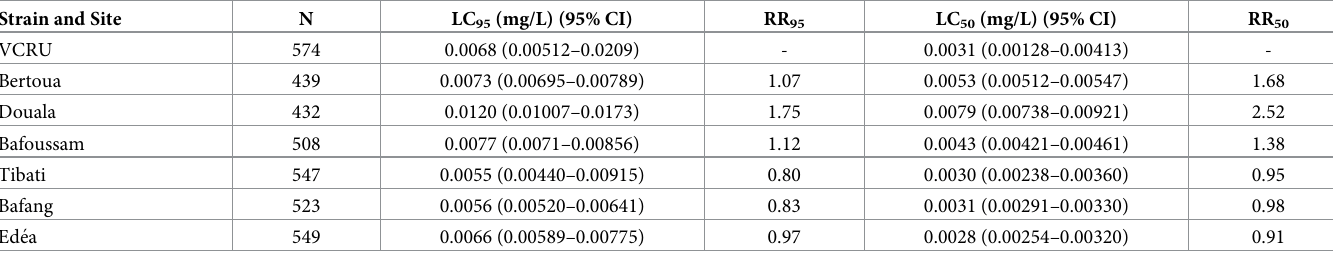
LC 95 and LC 50: 95 and 50% lethal concentrations; CI: confidence interval; RR: resistance ratio; VCRU: Vector Control Research